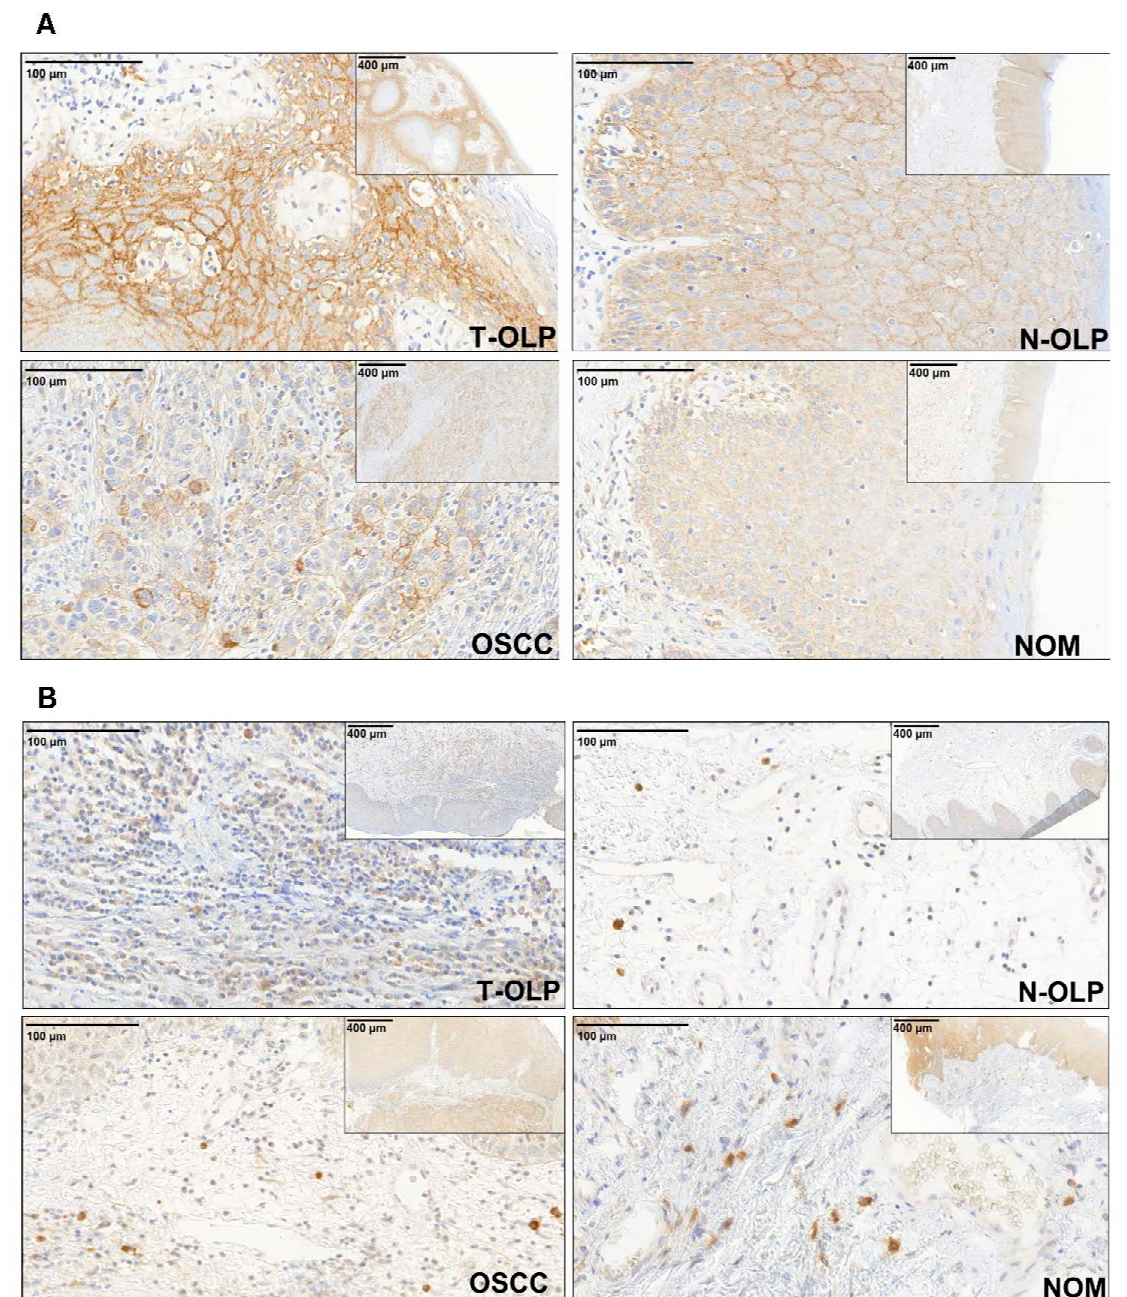
Figure 2. Immunohistochemical expression analysis of PD-L1. The expression of the protein was separately analyzed in the epithelial ( A ) and subepithelial ( B ) compartment. The expression varies in the different tissue specimens. PD-L1 is visibly overexpressed in the epithelial compartment of T-OLP and OSCC compared to N-OLP and NOM.